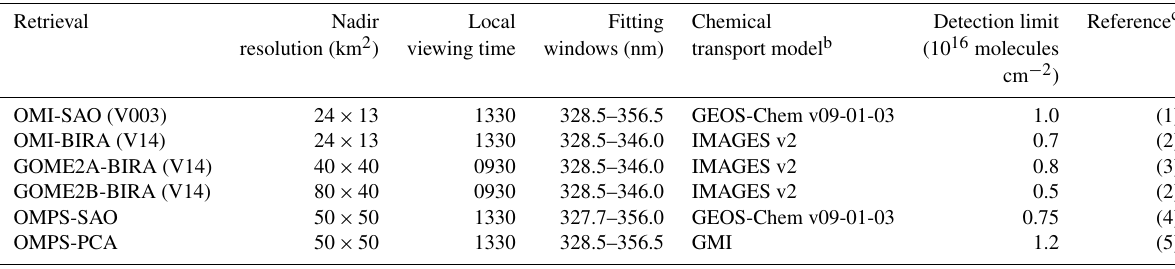
Table 1. Satellite HCHO products validated and intercompared in this work a . Retrieval Nadir Local Fitting Chemical Detection limit Reference c resolution (km 2 ) viewing time windows